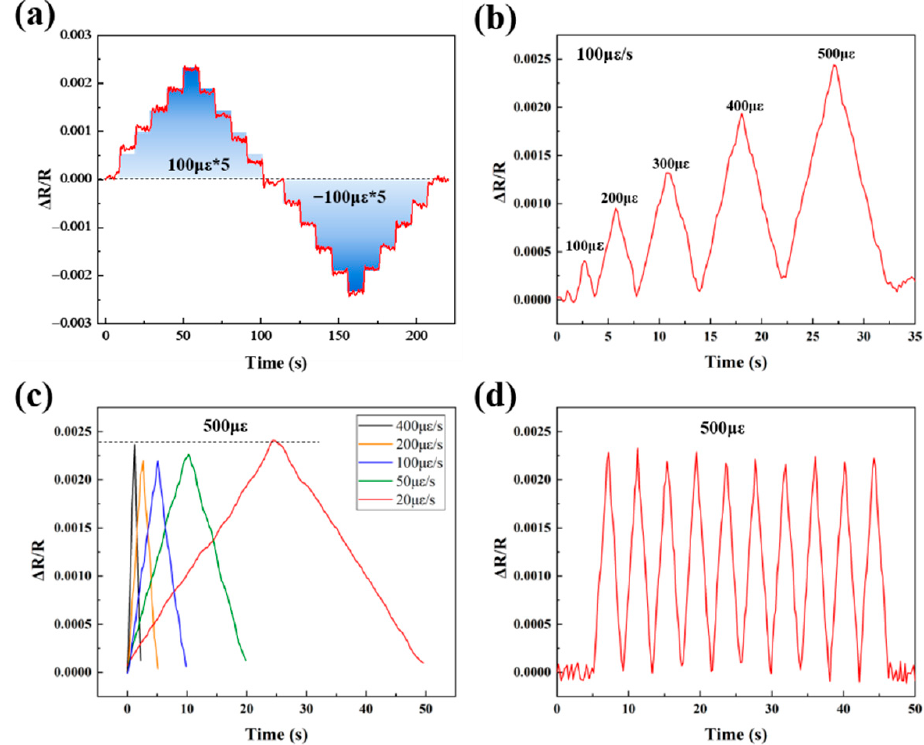
Figure 6. Piezoresistive response of the ZrB 2 (60 wt%)/SiCN TFSG: ( a ) The static response; ( b ) The response of different strain quantities at a constant strain rate (100 µε /s); ( c ) The response at different strain rates; ( d ) The cyclic response.